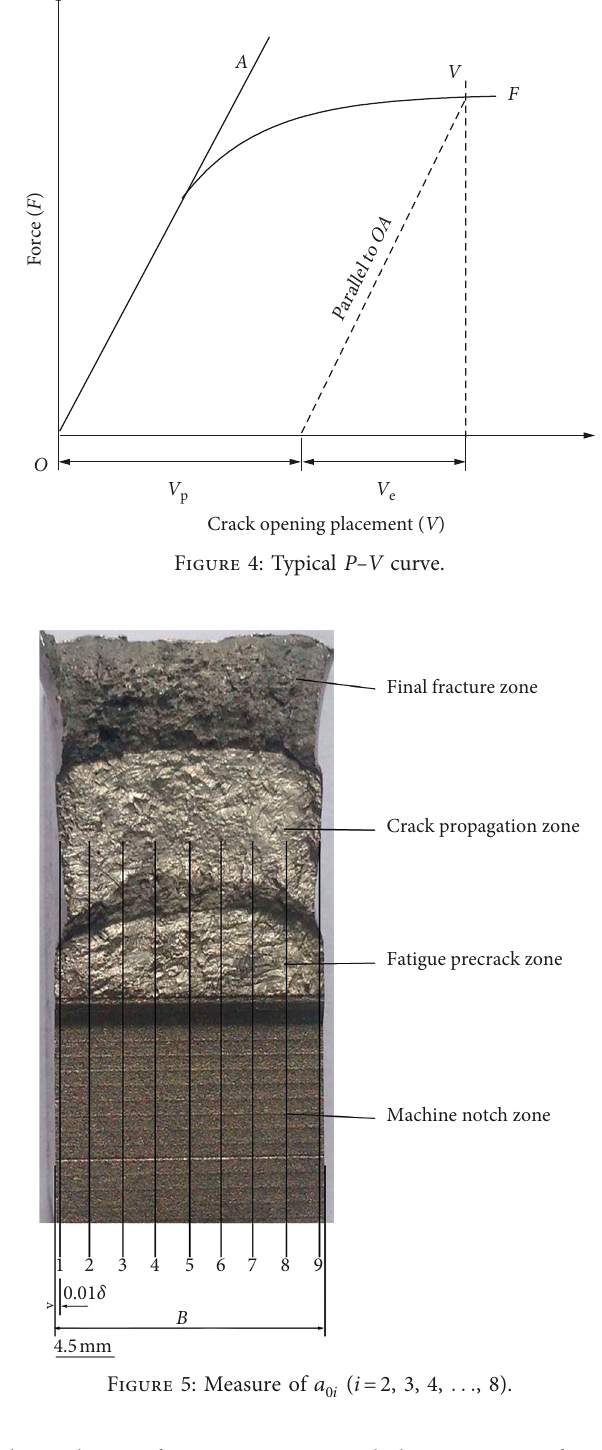
Figure 6. After mechanical thinning to 50 µ m, the TEM